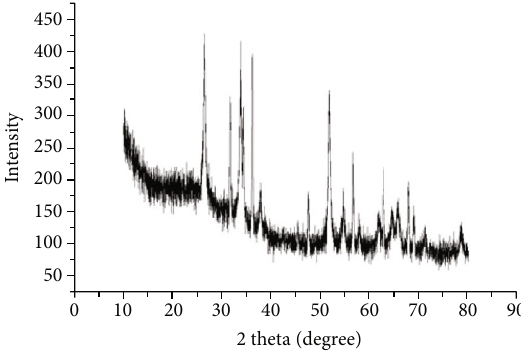
Figure 1: XRD patterns for CoF precipitation